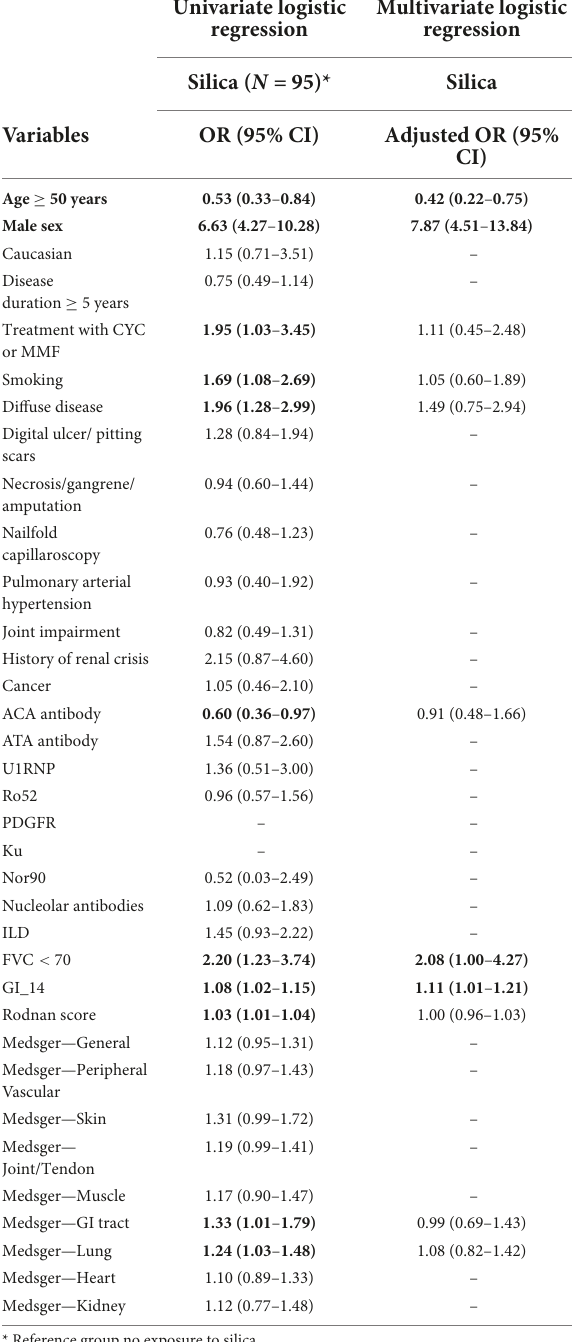
TABLE 2 Univariate and multivariate logistic regression model for factors associated with exposure to silica among all study sample. Univariate logistic